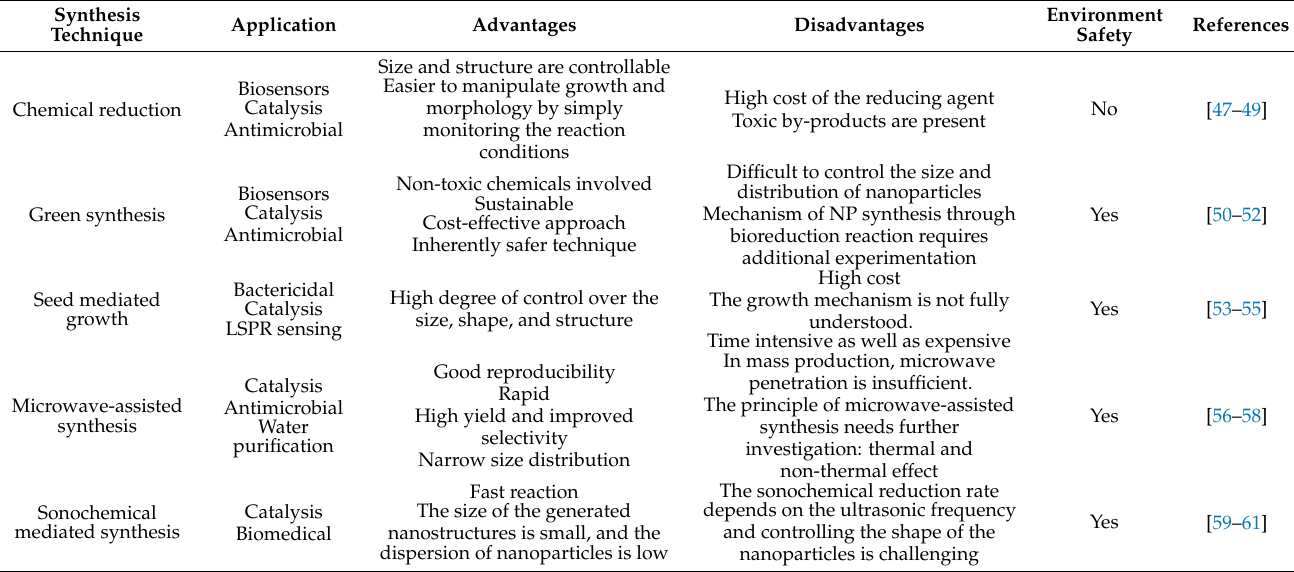
Table 1. Primary advantages and disadvantages of different syntheses of silver nanoparticles. 189